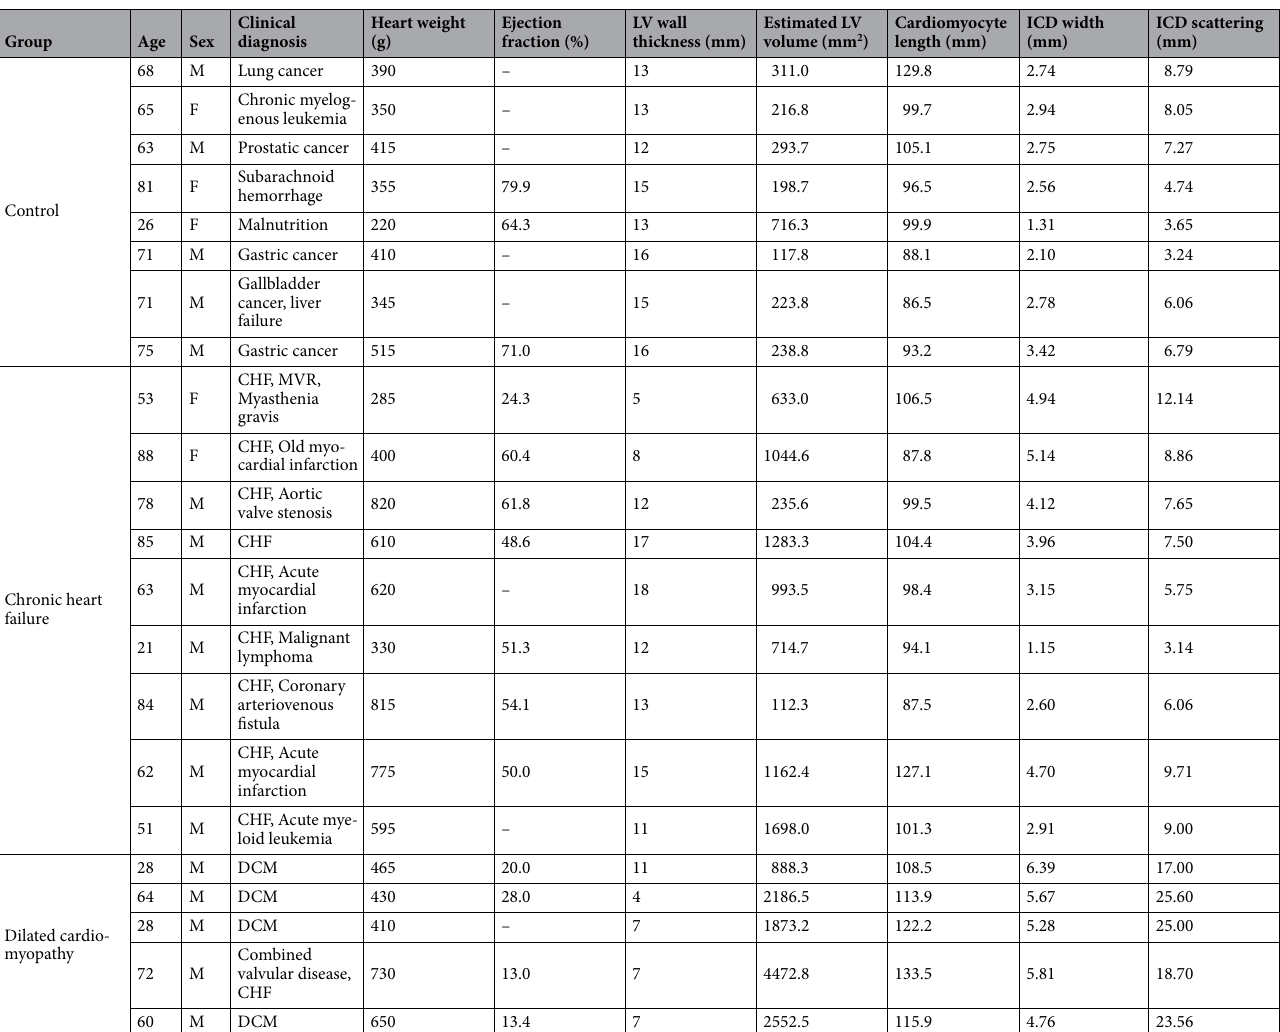
groups (control, CHF, and DCM) based on the clinical diagnoses and histological findings. The average ages of the patients in each group were as follows: control, 65.0 years; CHF, 65.0 years; and DCM, 50.4 years. The patients in the DCM group were younger than those in the other two groups; in addition, all DCM patients were male. Average heart weights in each group were as follows: control, 375.0 g; CHF, 583.3 g; and DCM, 537.0 g. In each case, the cardiomyocyte length, ICD width, and ICD scattering were all inversely correlated with the EF and positively correlated with the estimated LV volume. CHF chronic heart failure, DCM dilated cardiomyopathy, ICD intercalated disc, LV left ventricle, MVR mitral valve